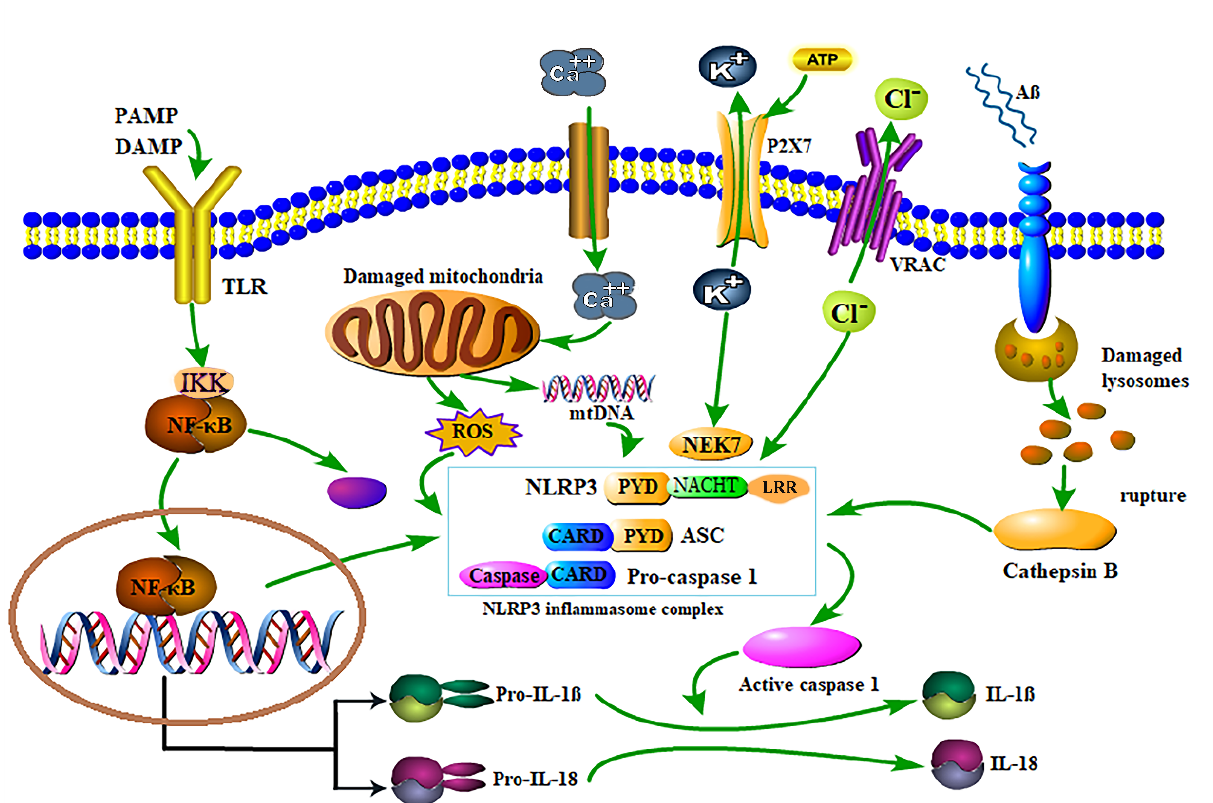
Figure 1. Schematic diagram of NLRP3 inflammasome activation. After exposure to PAMP or DAMP, TLR is phosphorylated, and IκB kinase (IKK) is activated, leading to IκB protein phosphorylation and ubiquitination, IκB protein degradation; NF-κB dimer is released to activate NF-κB, and thus promotes the assembly and activation of NLRP3 inflammasome, leading to proteolysis and pro-CASP1 activation to form active CASP1 dimers, thereby pushing pro-IL-18 and pro-IL-1β to IL-18 and IL-1β. Extracellular ATP can induce K + efflux through P2X7-dependent pores, and the low K + state in the cell promotes the binding of downstream never in mitosis A (NIMA)-related kinase 7 (NEK7) molecules and NLRP3, thereby mediating the activation of CASP1. Damaged mitochondria can release ROS and mtDNA, and ROS can promote the assembly and activation of NLRP3 inflammasomes, and mtRNA can promote the activation of CASP1, and calcium flux is also involved in these processes. At the same time, Cl – outflow through the volume-regulated anion channel (VRAC) is also conducive to the activation of NLRP3 inflammasome. The phagocytosis of Aβ results in lysosomal rupture and releases lysosomal content, such as cathepsin B, which induced the NLRP3 inflammasome assembly and activation. When NLRP3 inflammasome was activated, it catalyzed pro-CASP1 into CASP1, and thus facilitating the secretion and expression of mature IL-1β and